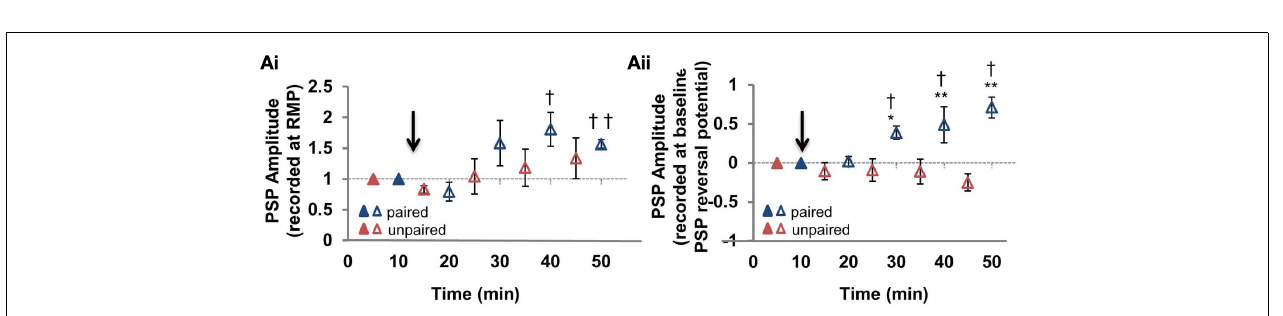
FIGURE 4 | Summary of disinhibition-mediated LTP pathway specificity. (Ai) Summary of the change in mixed PSP amplitude measured from the resting membrane potential, at the paired and unpaired pathways ( n = 6). (Aii) Summary of the change in mixed PSP amplitude measured from the initial PSP reversal potential [for the same cells as in (Ai) ]. Blue triangles denote paired pathways, red triangles denote unpaired pathways; filled triangles represent baseline recordings,